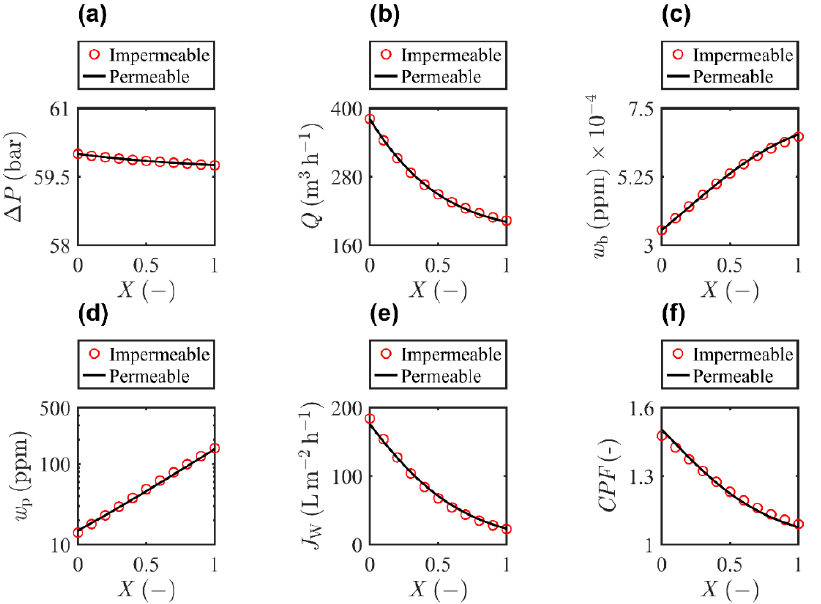
Figure 11. The simulated results at the system level using the impermeable and permeable wall